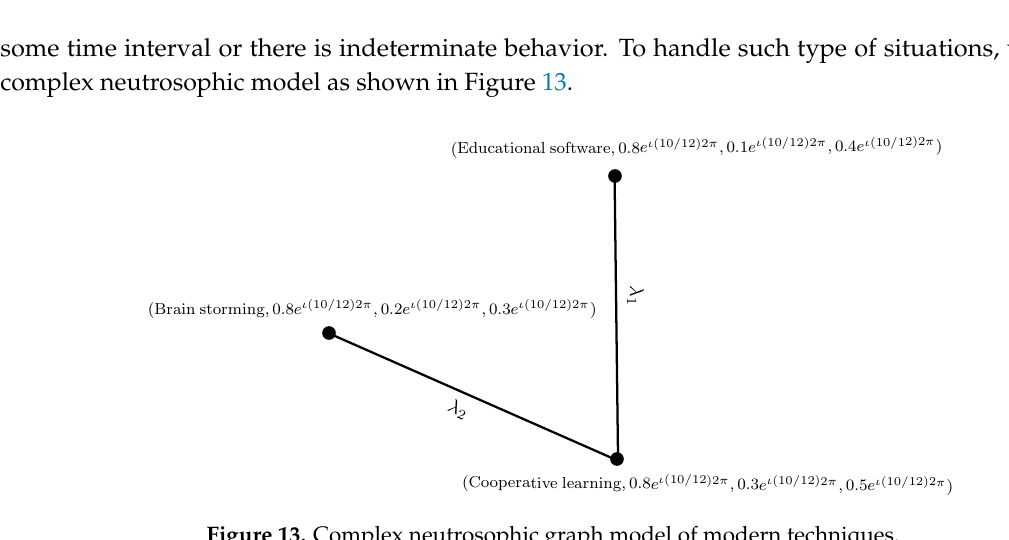
Figure 13. Complex neutrosophic graph model of modern techniques.